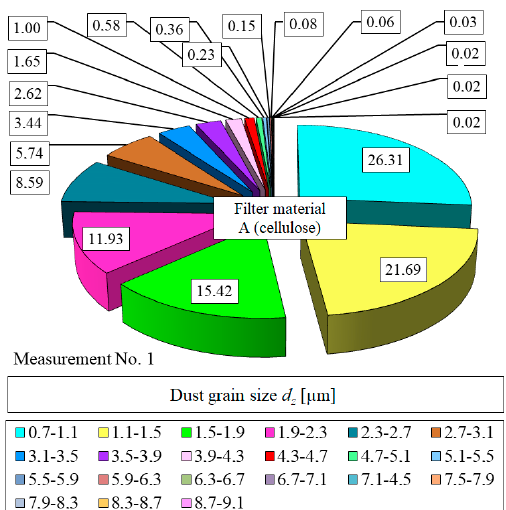
Figure 11. Particle size distribution in the air downstream of the filter element A after reaching the dust mass loading k mA = 2.68 g/m 2 (measurement no. 1).